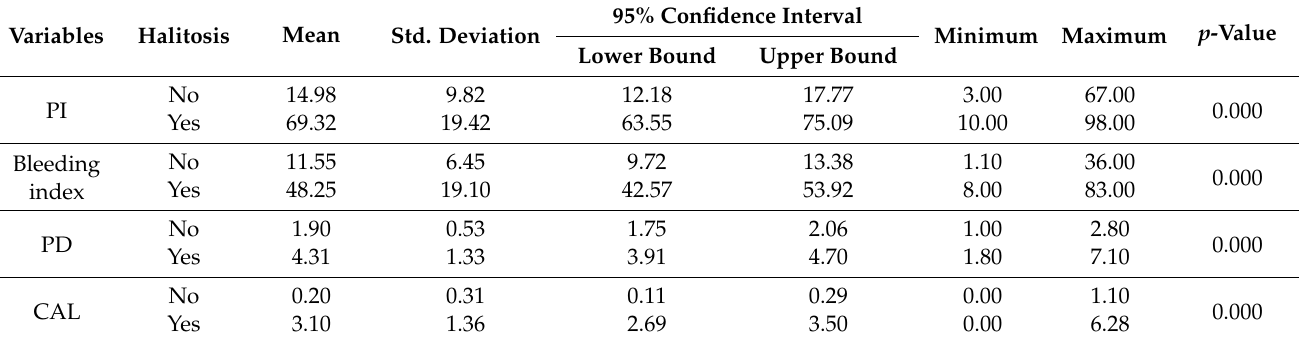
Table 5. Comparison of different periodontal variables in relation to presence/absence of halitosis ( n = 96). Variables